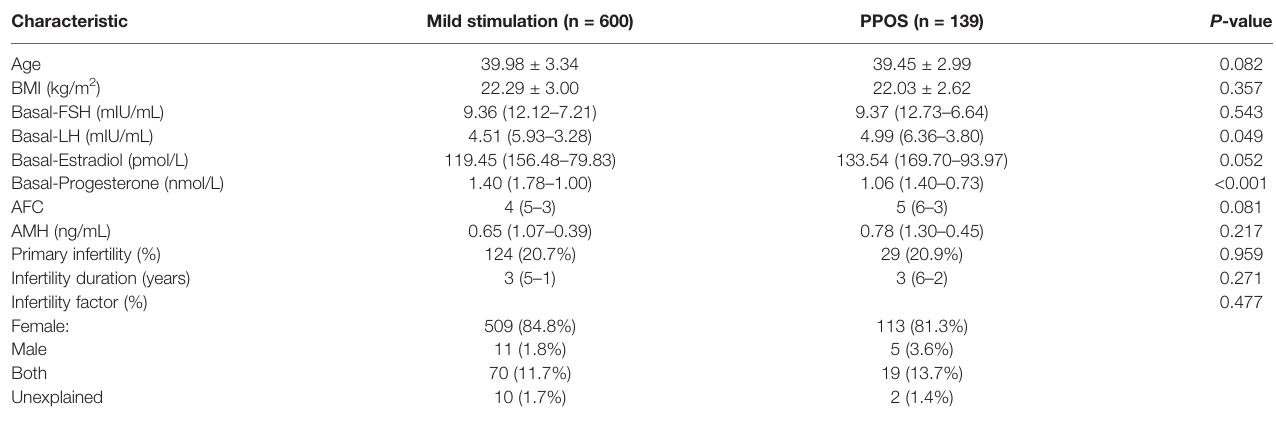
TABLE 1 | Demographics and basal characteristics of patients in both